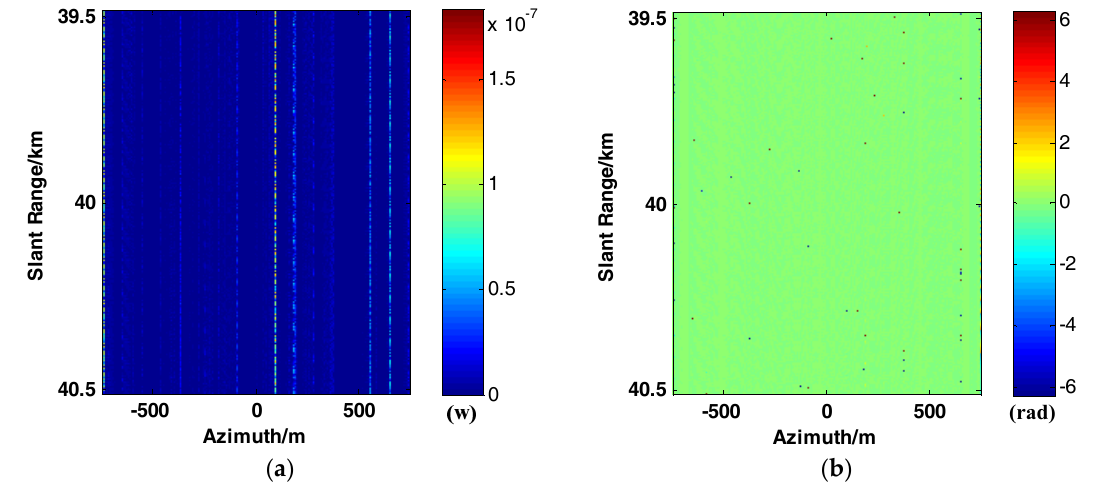
Figure 6. Magnitude and phase errors between the non ‐ motion ‐ error echo and data recovered by BLUE algorithm. ( a , b ) are magnitude and phase errors, respectively.